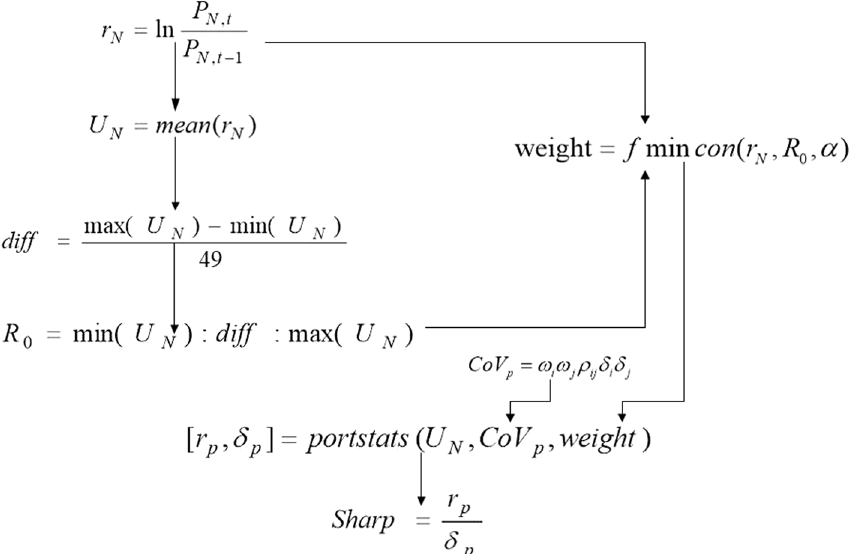
Fig. 6 Computing of Sharpe ratio of the